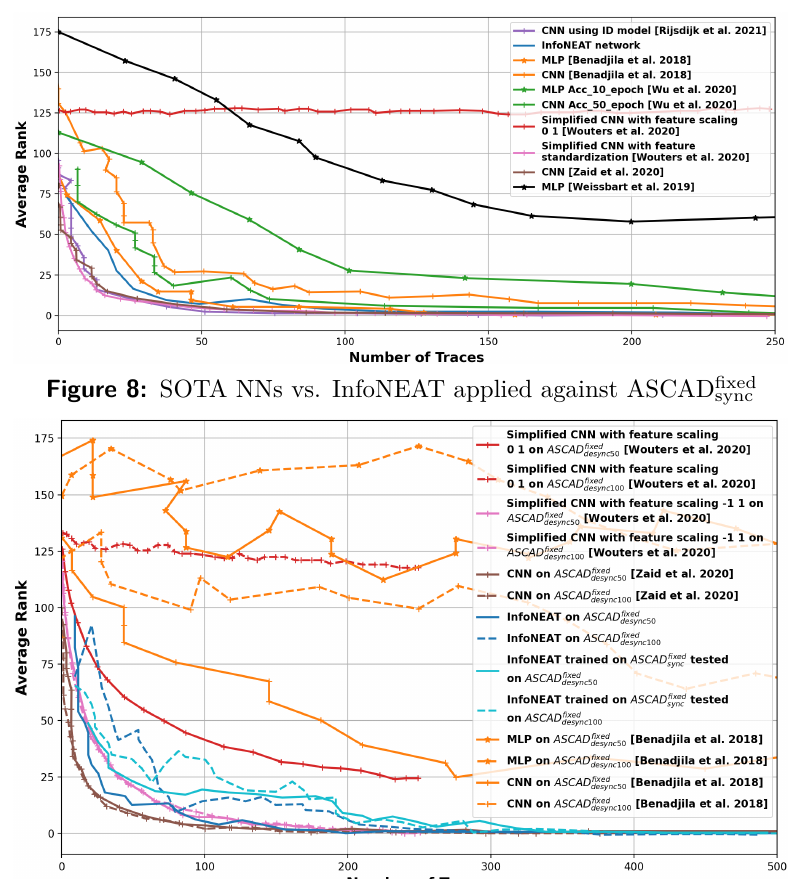
Figure 9: Average rank for the ASCAD fixed desync